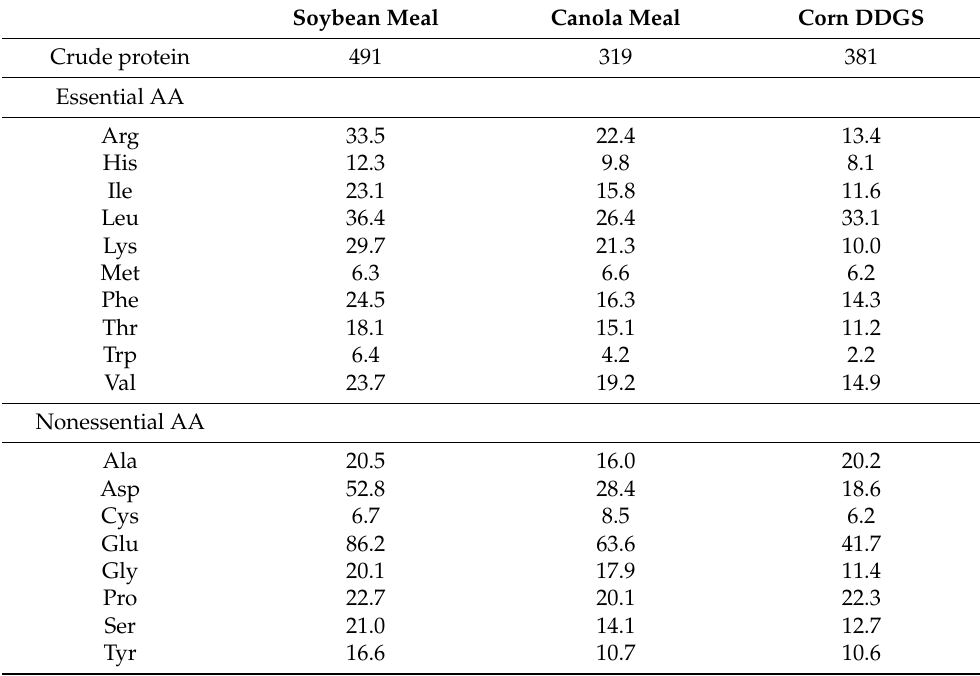
Table 1. Chemical composition (g/kg, as-fed basis) of protein feedstuffs used in experimental